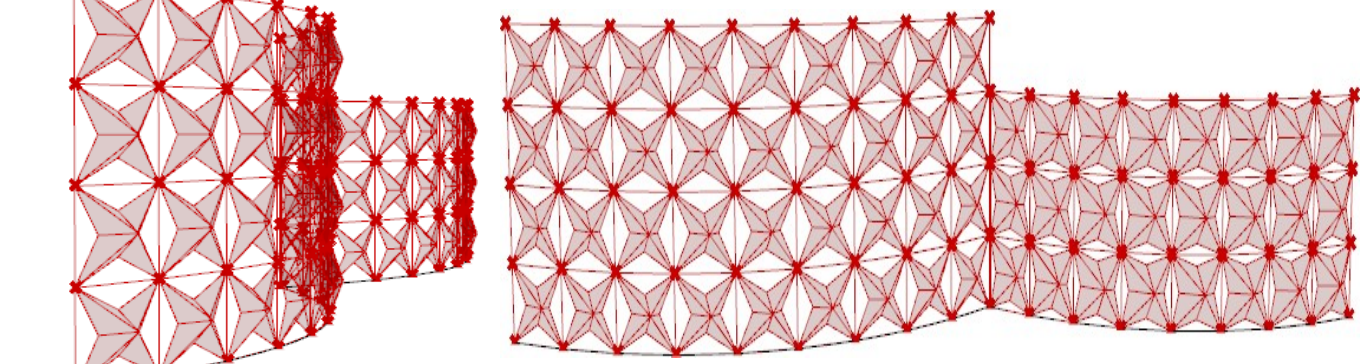
Figure 20. Alternative 1. Grasshopper Generated.